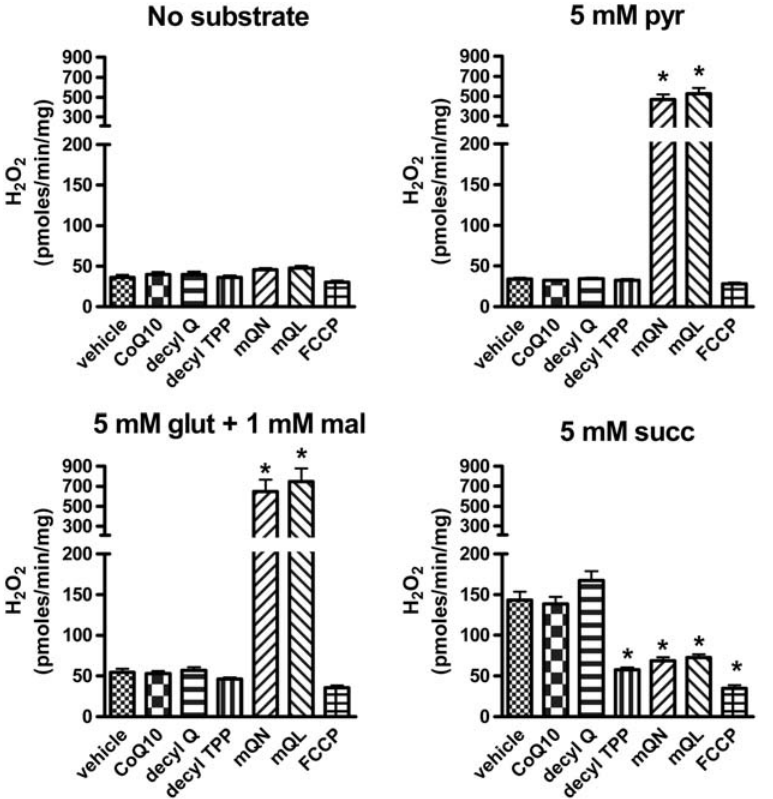
Figure 2. Effect of mitoquinone (mQN) and mitoquinol (mQL) compared to control compounds on H 2 O 2 production by isolated BAE mitochondria fueled by different substrates. Mitochondria were incubated in respiratory buffer under state 4 conditions fueled by pyruvate (pyr), glutamate (glut) + malate (mal), or succinate (succ) as indicated above the individual graphs. Added compounds (1.0 m M), vehicle, or FCCP (2.5 m M) were present as indicated on the X-axis. Data represent mean 6 SE, * p , 0.01 compared to vehicle by ANOVA. n=6 mitochondrial preparations for all data points. Each individual value represents the mean of two replicate wells.